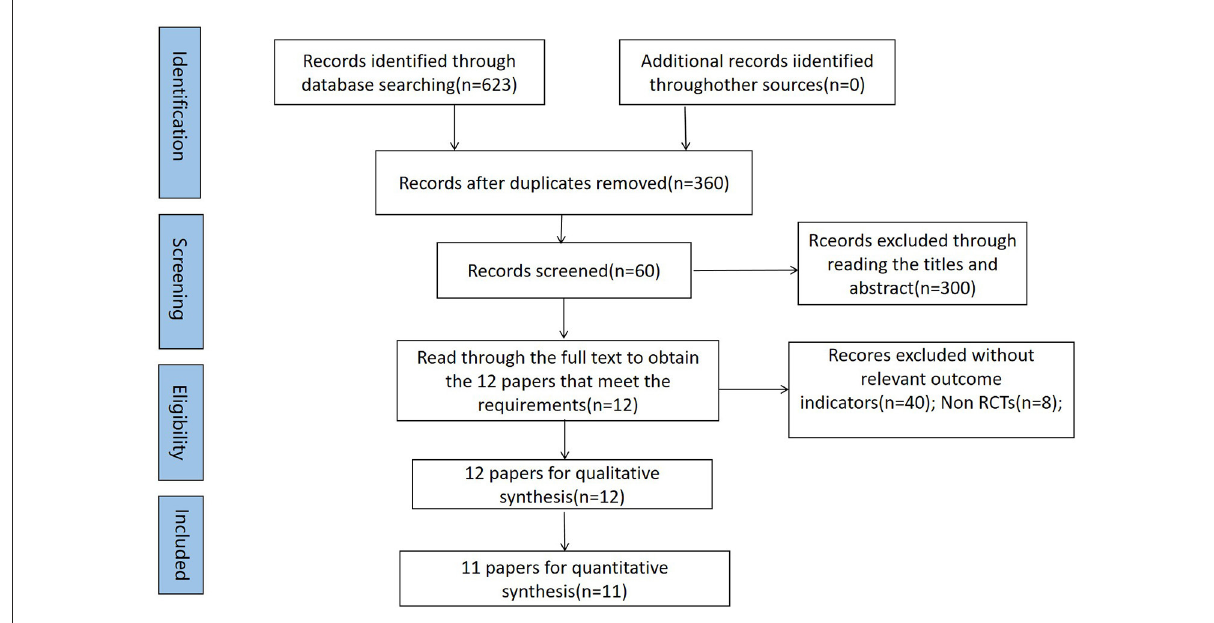
FIGURE1 PRISMA flow diagram showing study identification and